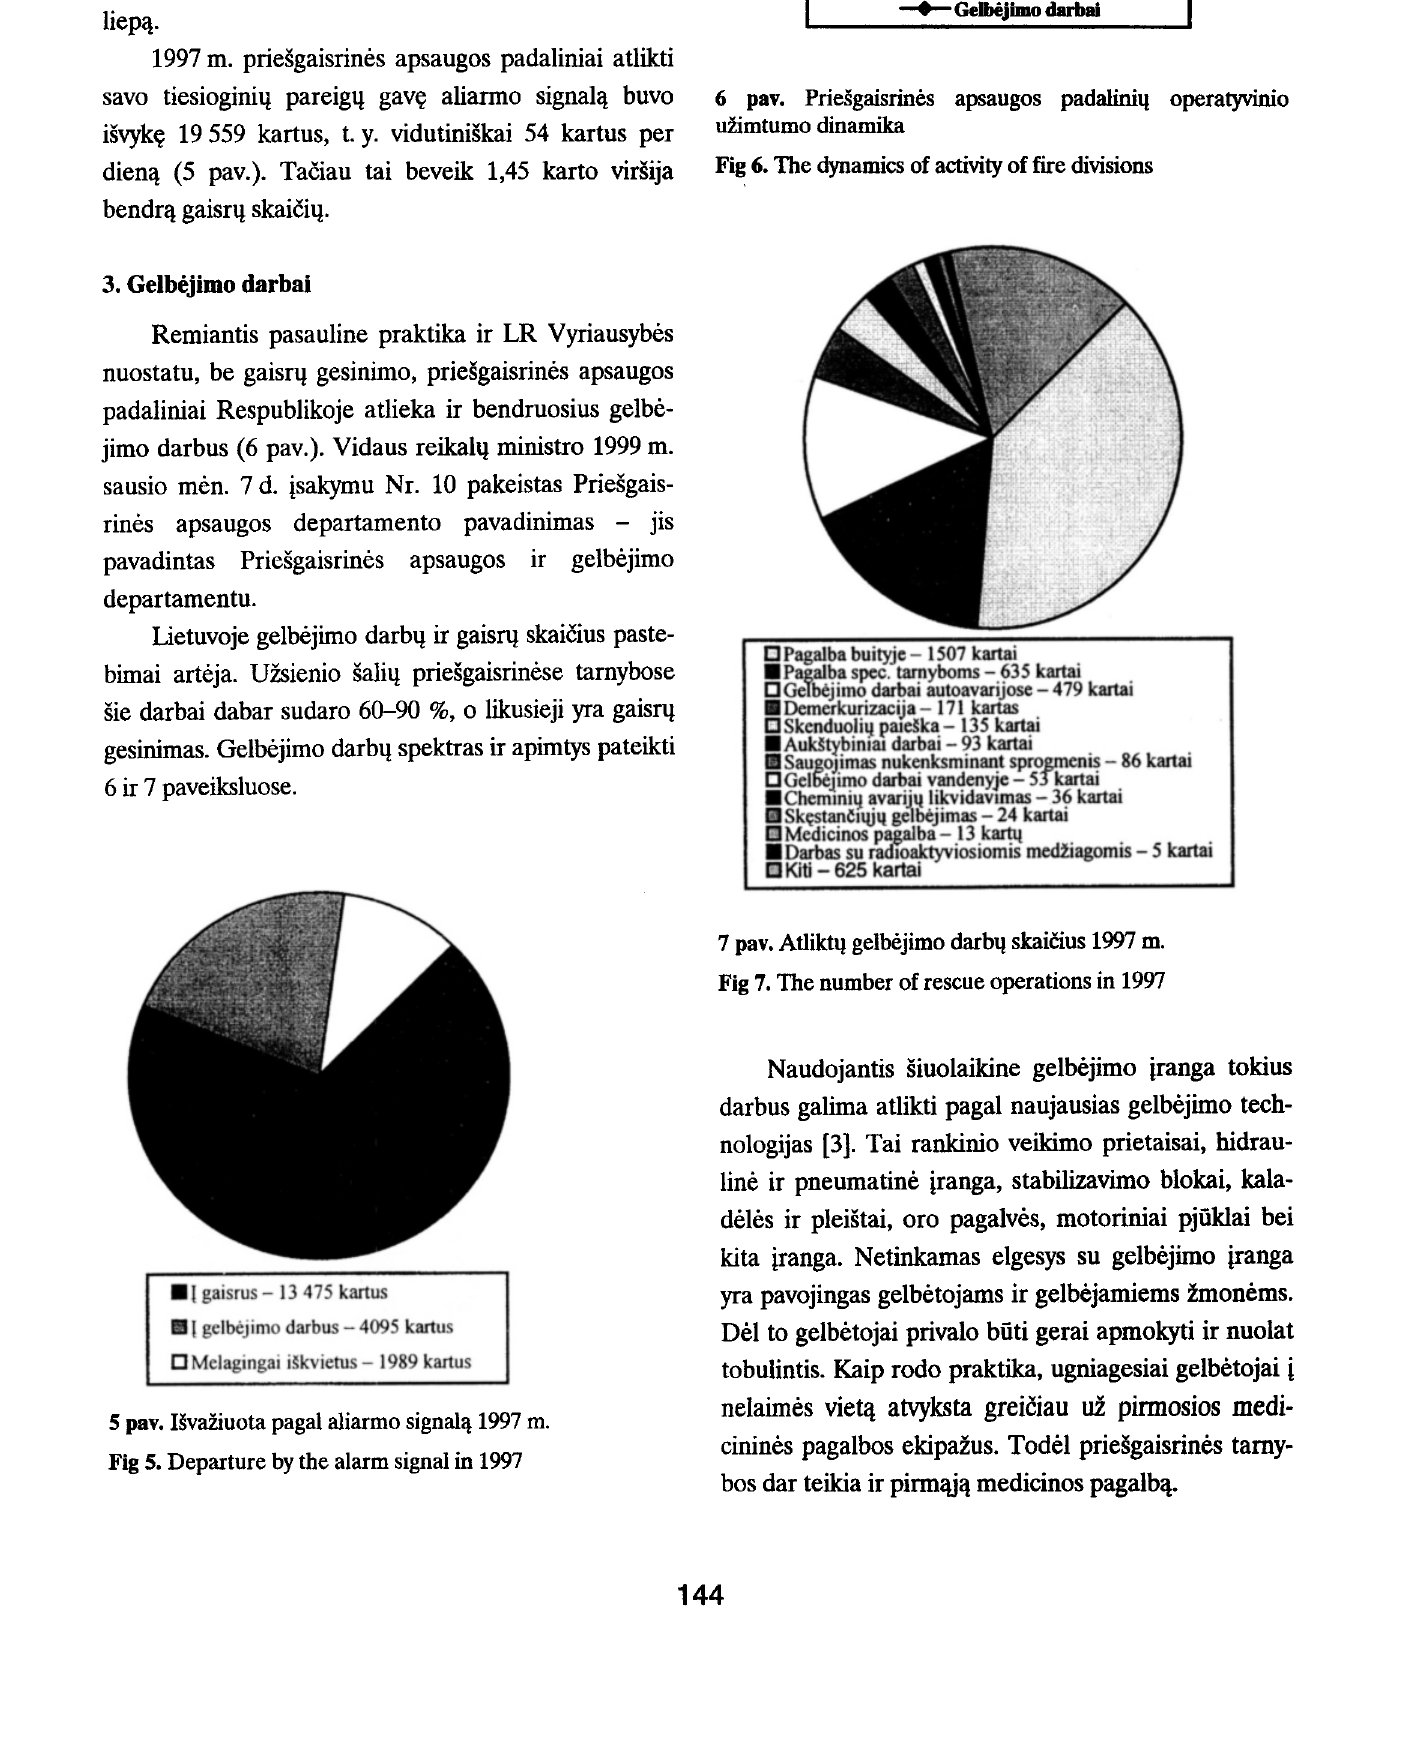
Fig 6. The dynamics of activity of fire divisions